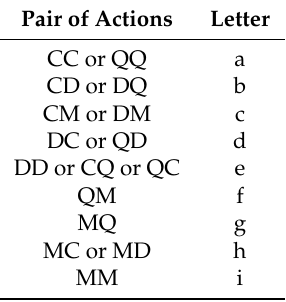
Table 8. Associating a letter to each possible outcome of the quantum PD